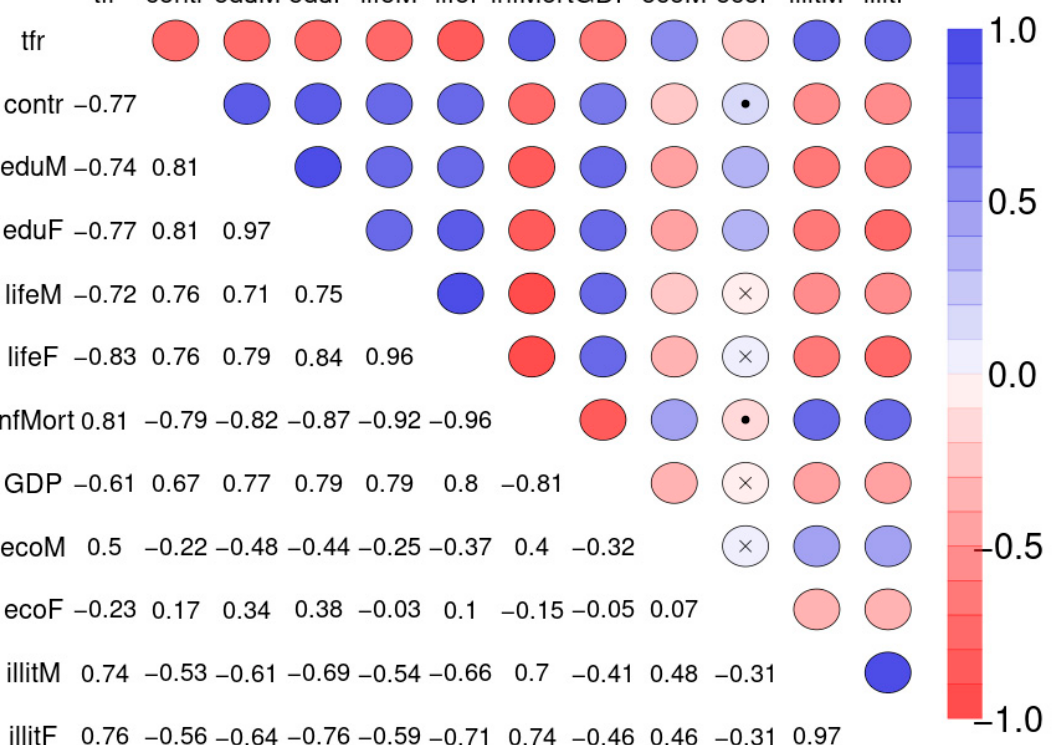
Figure 10. Spearman correlation matrix for pairwise correlations between total fertility rate (number of children per woman, tfr), percentage of married women using any method of contraception (contr), average number of years of father’s (eduM), and mother’s education (eduF), life expectancy at birth for males (lifeM), and females (lifeF), number of infant deaths per 1000 live births (infMort), gross domestic product per person in US dollars (GDP), percentage of men and women who are economically active (ecoM, ecoF), and percentage of males and females age 15 years and older who are illiterate (illitM, illitF).